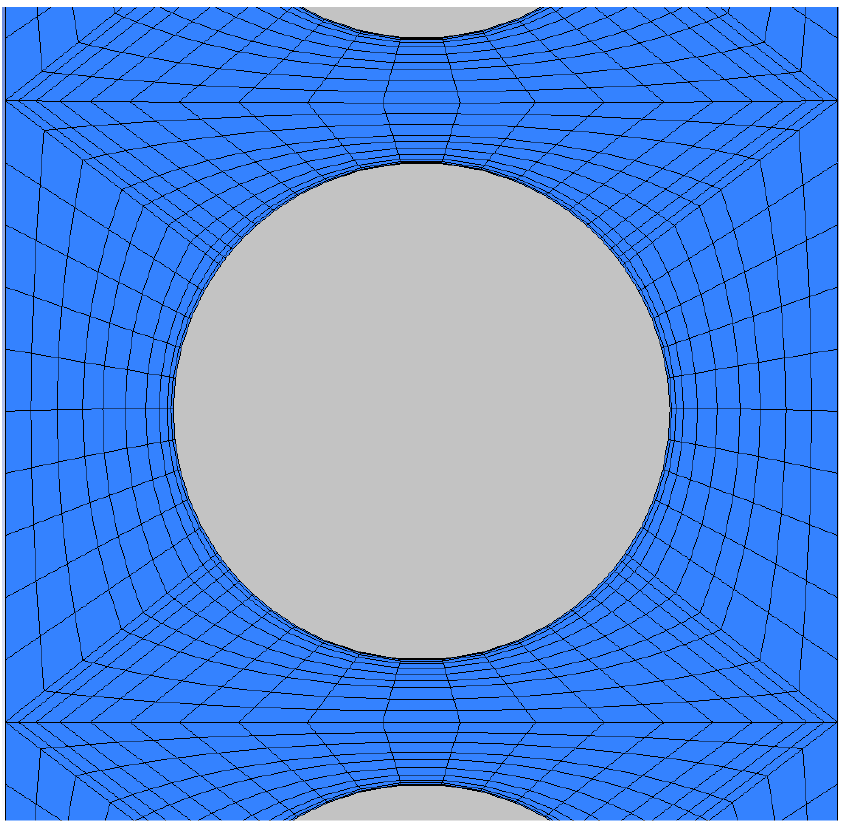
Figure A1. Results of mesh dependency analysis for 3D flow simulations around drums.